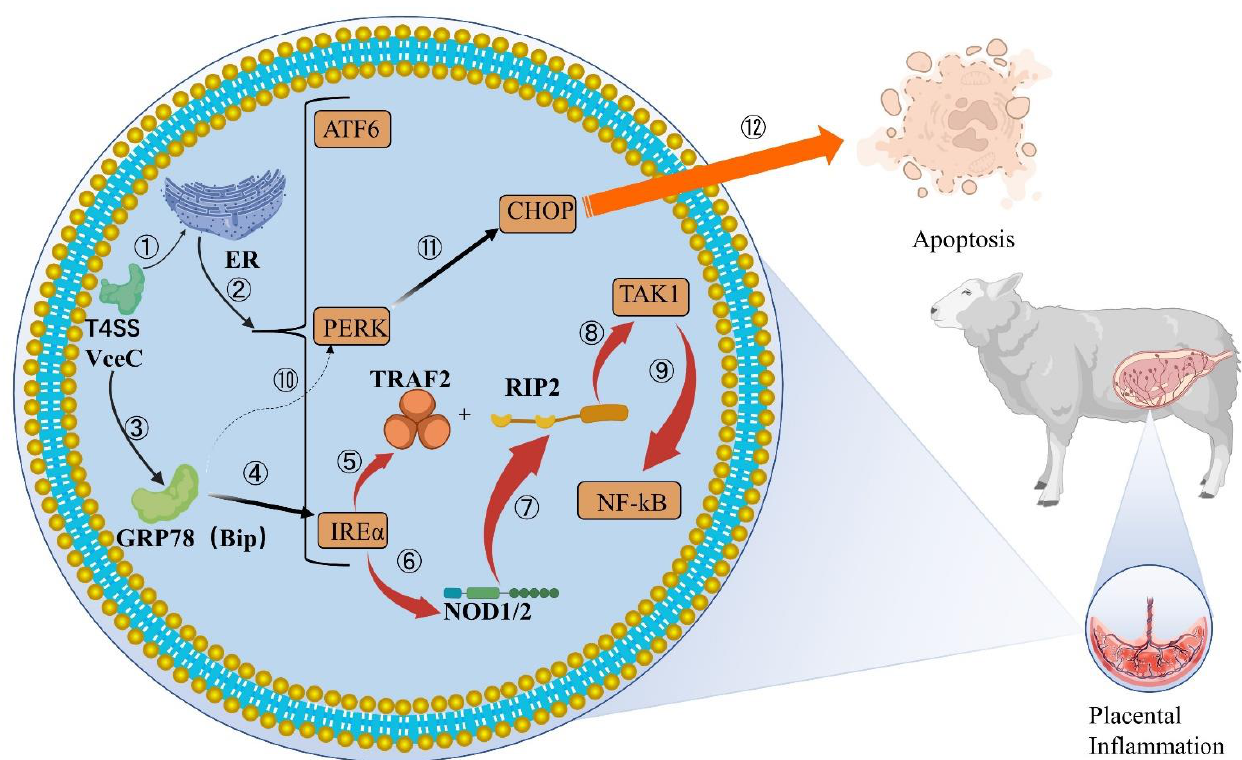
Figure 2. VceC mediates IREα inflammatory responses and apoptosis in cells. ①② : VceC ectopic to rough ER through Brucella T4SS. RER is stimulated by VceC and causes ER stress to increase unfolded products, and prolonged stress leads to UPR, activation of ATF6, PERK and IRE α metabolic pathways. ③④ : VceC binds to the GRP78 chaperone at the ER to induce the IRE α inflammatory pathway. ⑤ – ⑨ : IRE α is activated and recruits TRAF2 to the ER membrane and triggers NOD1/2 homo-oligomerization and activation. TRAF2 binds and k63-polyubiquitinates RIP2, both of which are involved in NOD1/2 signaling to mediate the collection of TAK1, ultimately activating NF- κB, thus increasing the levels of inflammatory factors such as IL-6, IL-12p40, and causing the placental